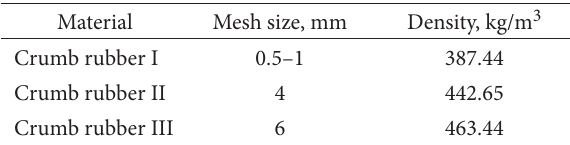
Table 2. Specifications of scrap-tire crumb rubber of different sizes